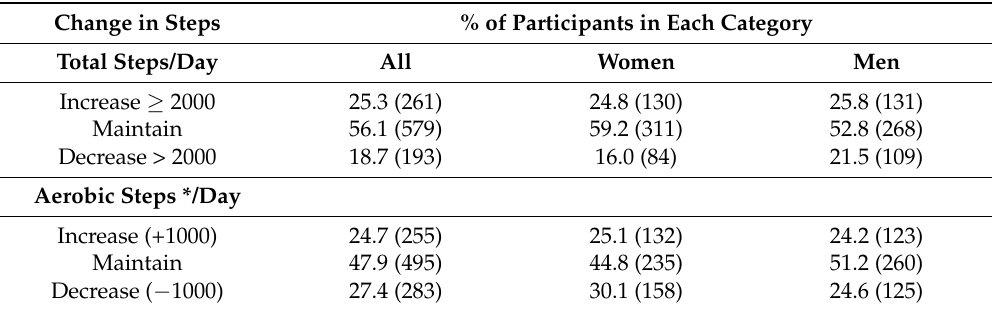
Table 1. Changes in daily steps and aerobic steps from 2007 to 2011, N =